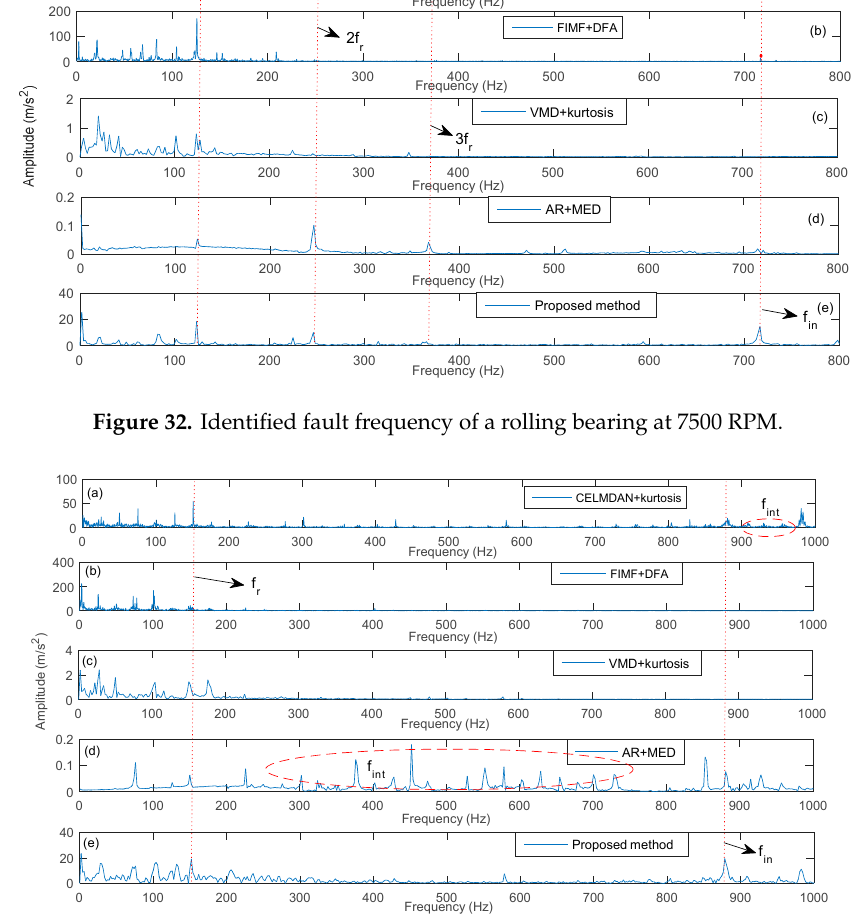
Figure 33. Identified fault frequency of a rolling bearing at 9000 RPM.